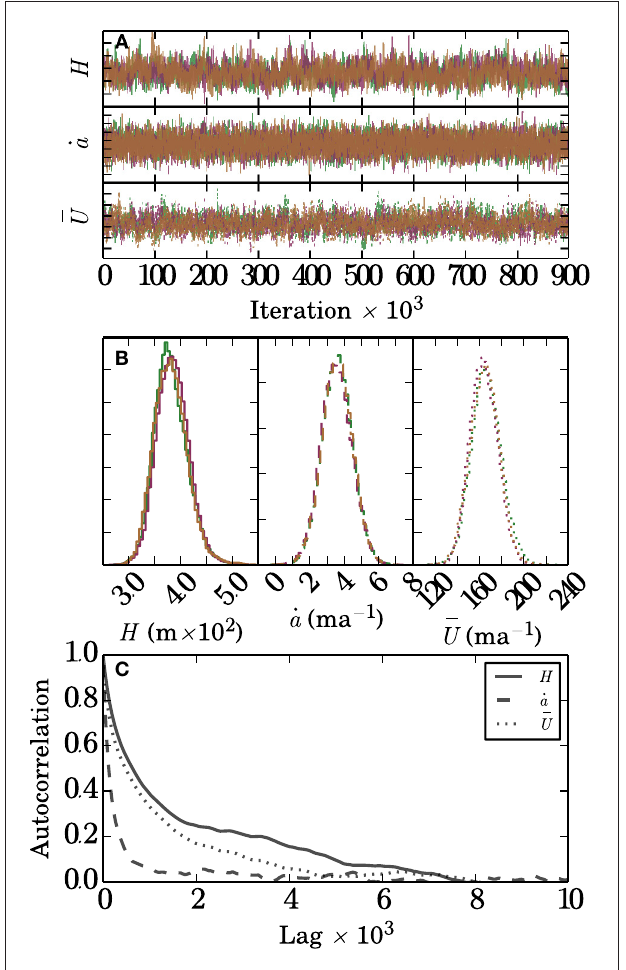
Figure 2C addresses a final numerical consideration. The